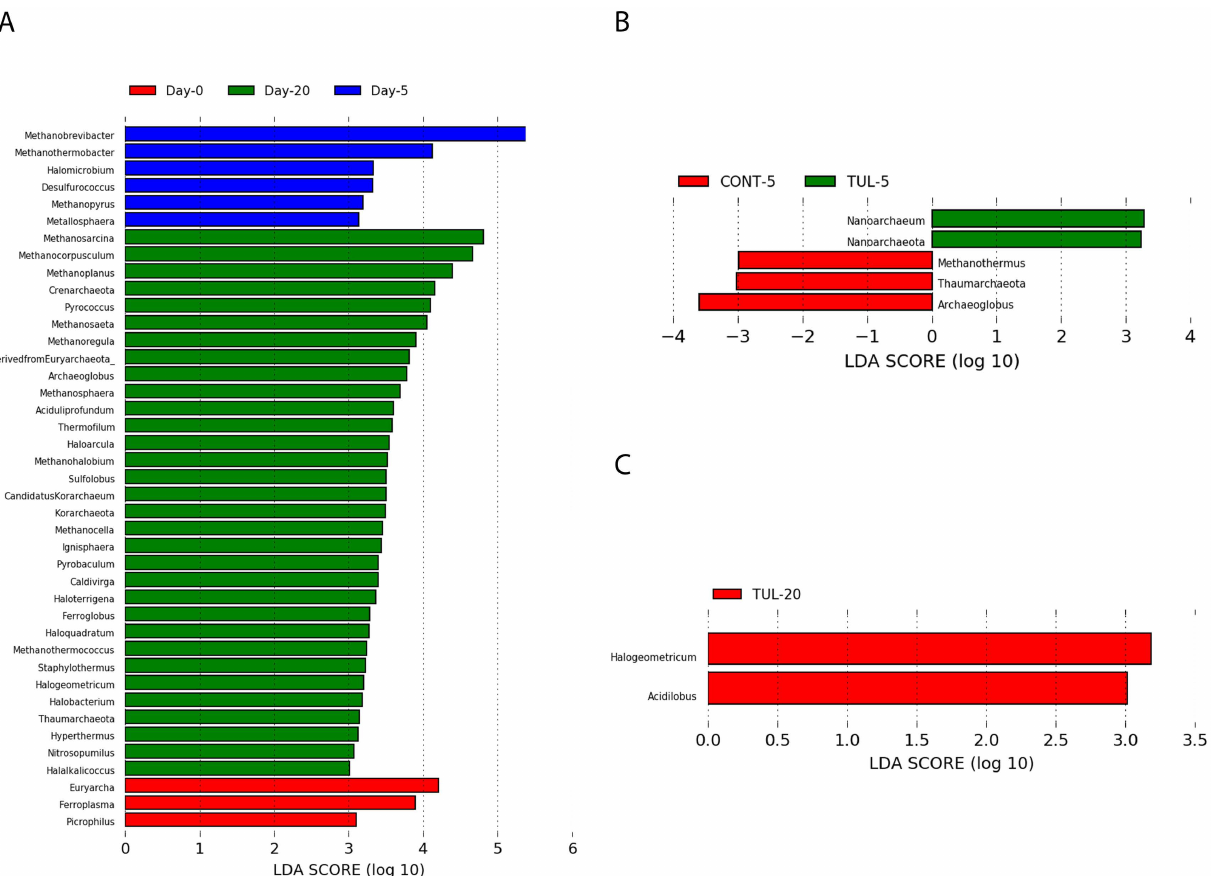
Figure 3. ( A ) Identification of indicator archaeal taxa associated with a statistically significant differential abundance between the different sampling days (0, 5, and 20). Identification of indicator archaeal taxa associated with a statistically significant differential abundance between the control (CONT) and tulathromycin (TUL)-treated piglets at days 5 ( B ) and 20 ( C ) of life. The top OTUs with the highest LDA score log 10 > 2.0 that discriminate between the CONT and TUL-treated piglets at each time point are depicted.